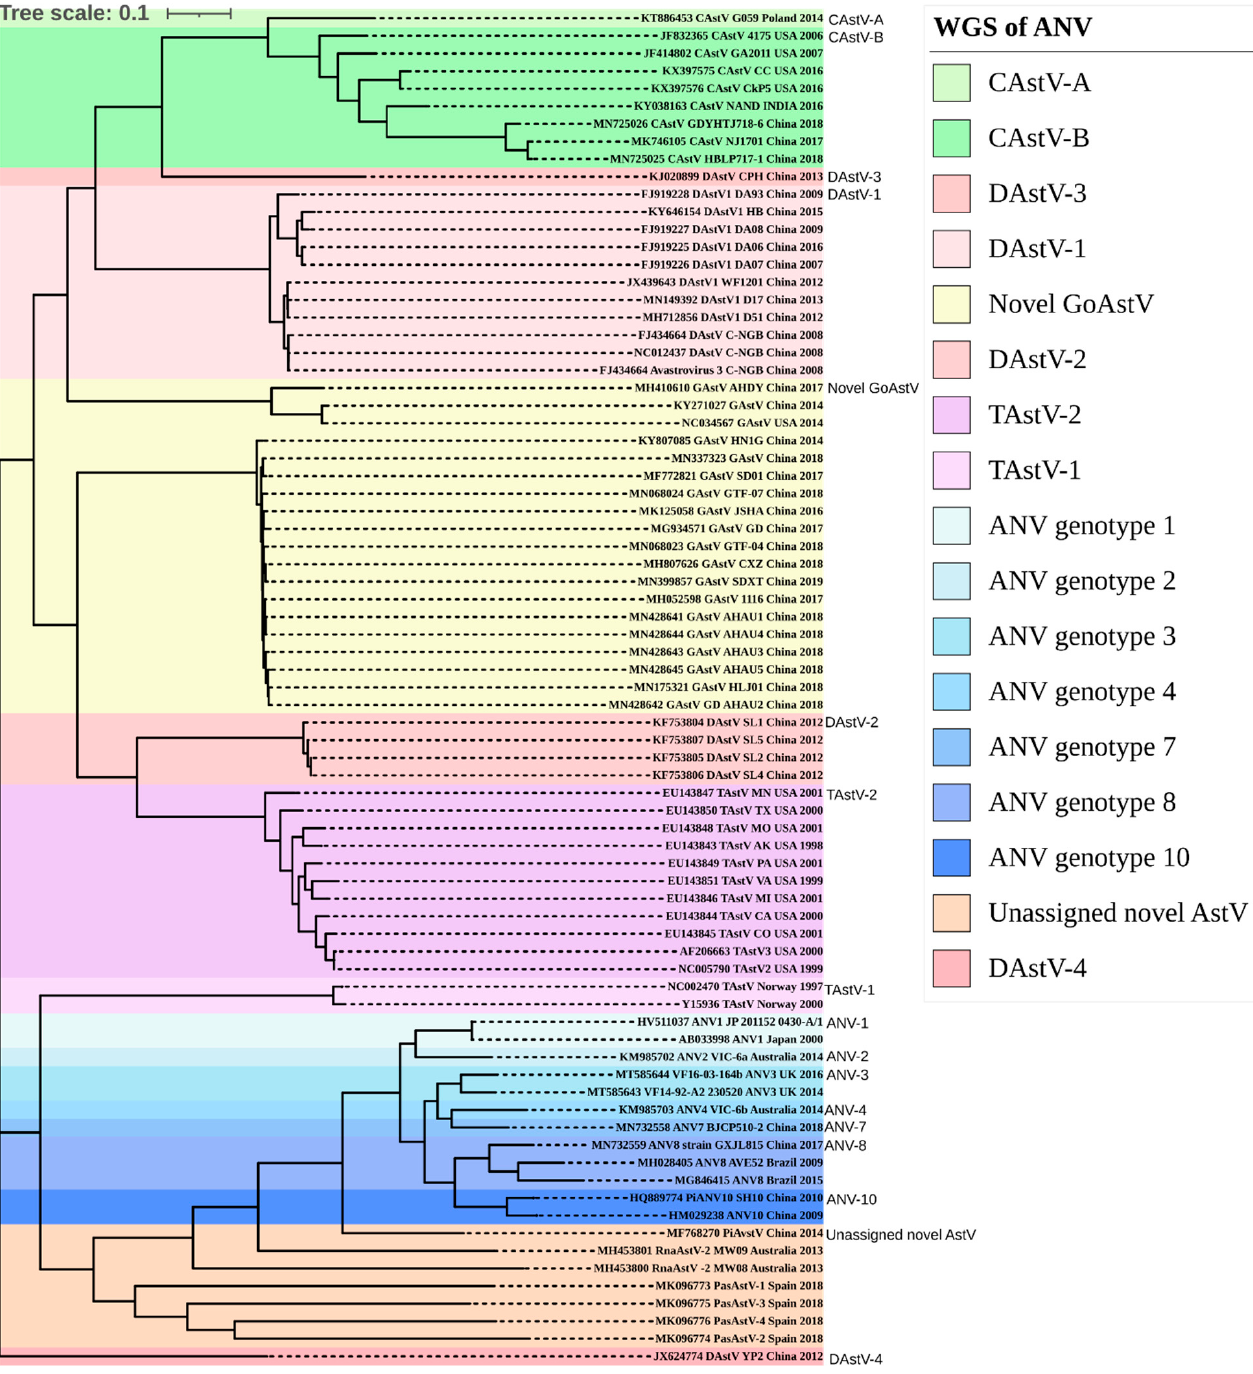
Figure 5. Astroviridae whole genome sequence (WGS) phylogeny. The Avastroviridae whole genome nucleotides of 78 sequences, starting from ORF1a phylogenetic analysis in MEGA X from MUSCLE-aligned sequences. Evolutionary history was inferred by maximum likelihood with bootstrapping of 1000 replicates. The tree was annotated into clades and ANV genotypes coloured blue with sequences from this study, with MT585643, VF14-92-A2, and MT585644 VF16-03-164b positioned in Avastrovirus genotype 3. Clade abbreviations; CAstV = Chicken astrovirus, DAstV = Duck astrovirus, GAstV = Goose astrovirus, ANV = Avian nephritis virus, and TAstV = turkey astrovirus.